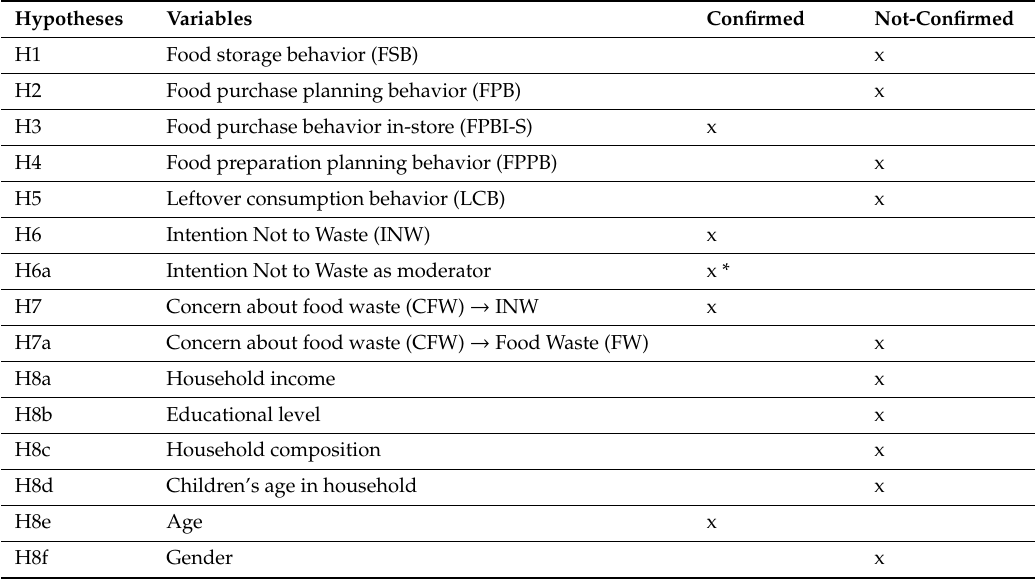
Table 9. Confirmed